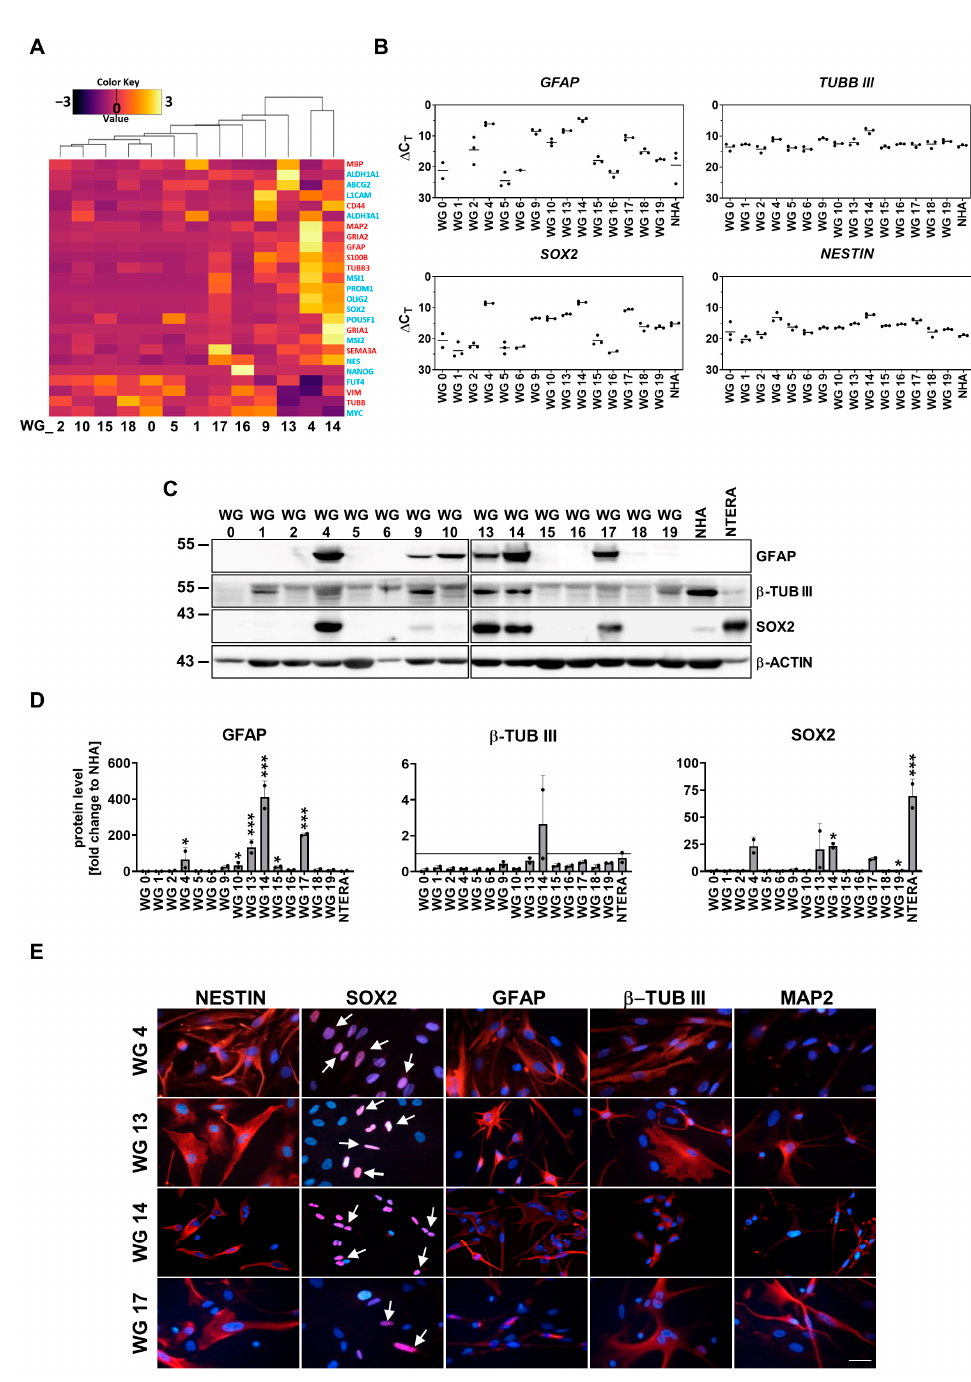
Figure 2. Stemness and differentiation markers across primary cell cultures. ( A ) RNA-seq of primary cell cultures represented as heatmap with stemness (indicated by blue color) and differentiation (red color) related genes. ( B ) Expression of selected differentiation ( GFAP, TUBBIII ) and stemness ( SOX2, NESTIN ) related genes in human patient-derived primary cultures and NHA as a control. The RT-qPCR data are shown as delta Ct values relative to the 18S expression. ( C ) Representative immunoblots showing GFAP, β -TUB III and SOX2 levels in glioma primary cultures, NHA and NTERA cells. ( D ) Quantification of immunoblots. The level of a protein of interest in control cells equals 1 and is marked by a solid black line. β -actin was used as a loading control. NHA serves as a non-malignant control, whereas NTERA serves as a positive control with stemness properties. Statistical analysis was performed using one way ANOVA with Dunnett’s post hoc